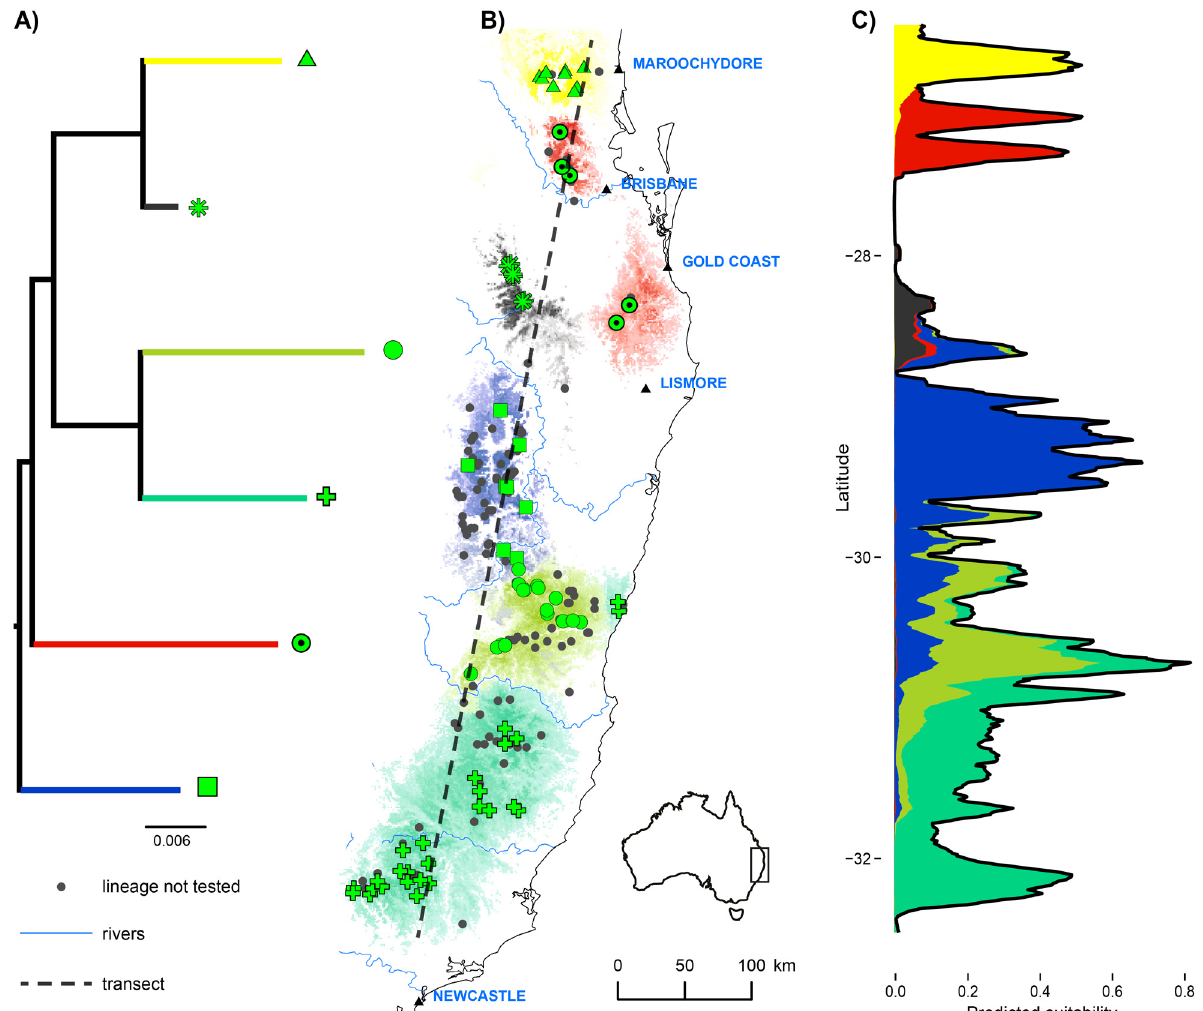
Fig 3. Example of lineage distribution models for 6 lineages of Saproscincus rosei . A) Phylogenetic relationships between the lineages. B) Known locations of each lineage (green symbols) are supplemented by locations of specimens (black dots) where the presence of the species is known, but not the lineage identity. For each lineage, the relative likelihood of occurrence is shown with colors matching the corresponding tree branch. C) The likelihood of occurrence of each lineage along the dashed transect in B is shown in the same colors. In this stacked plot, the total value (black line) is the predicted suitability for the species, partitioned between the lineages. Values for several lineages at the same location represent uncertainty of lineage occupation, not